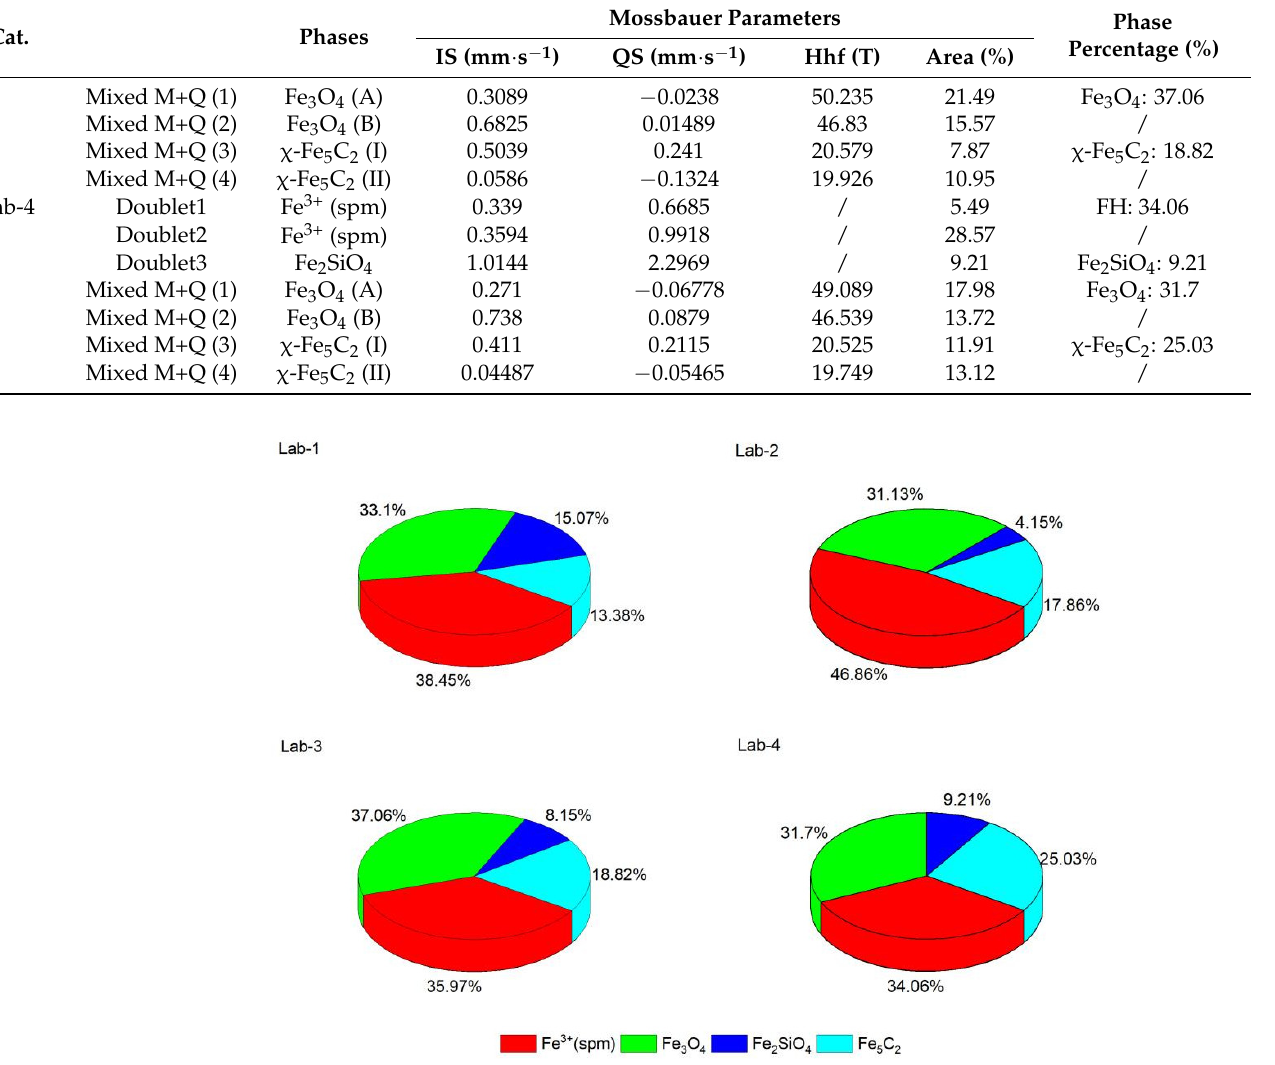
Figure 16. Relative contents of each phase acquired from MES over four spent catalyst samples.